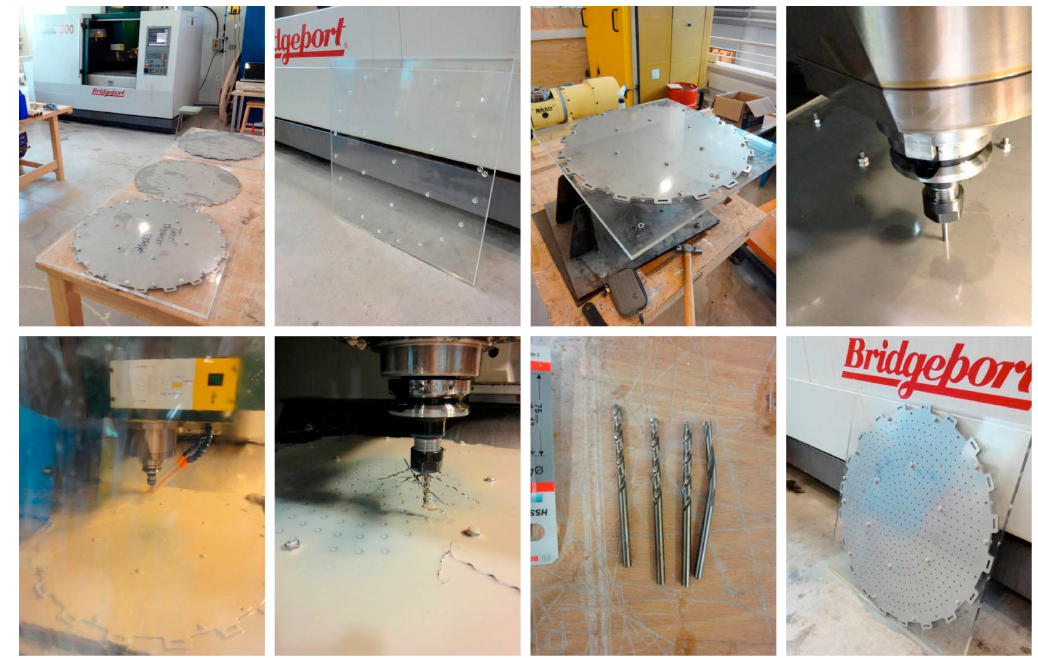
Figure 6. The RPT matrix plate pin hole drilling process employing a CNC milling machine for the task, (photos: Jorgensen, T. 2012).